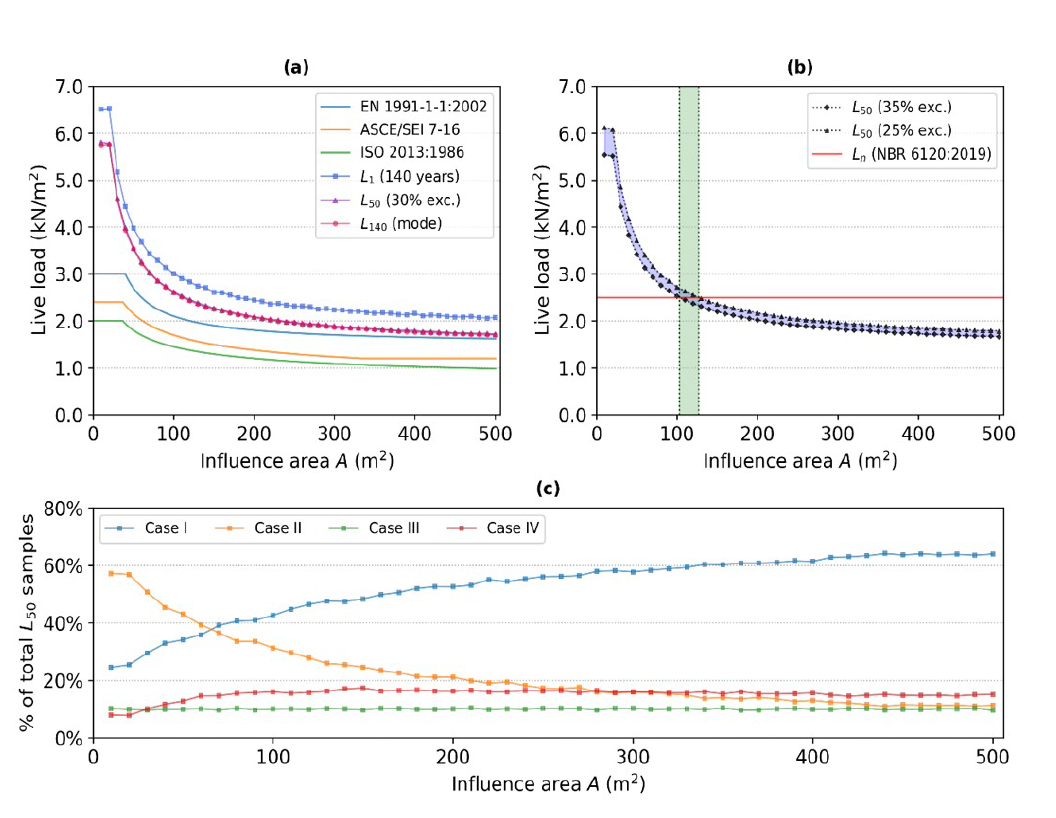
Figure 7. Simulated total live load for office